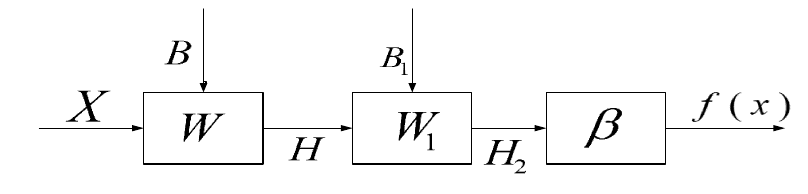
Figure 4. The work flow of the TELM.